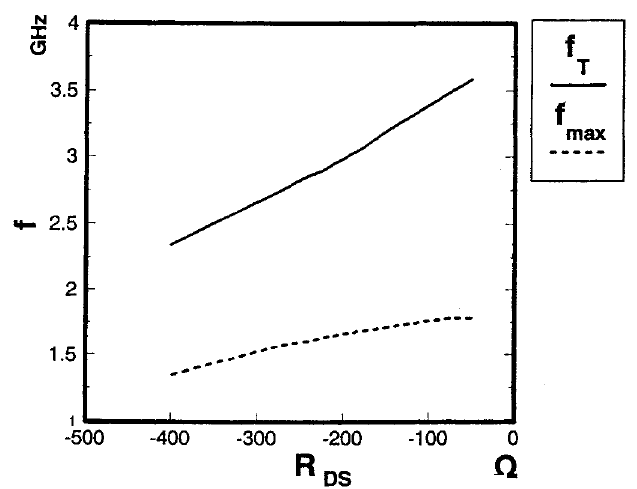
FIGURE 10 The dependence of R DS on frequency characteristics.